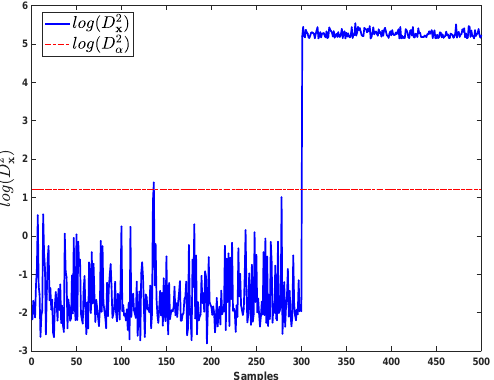
Figure 5. The fault detection results based on kNN for case 2 of numerical